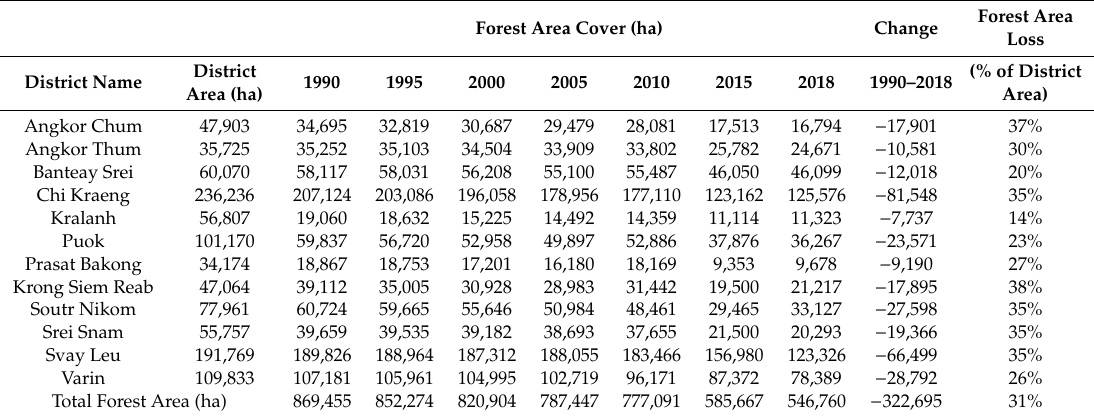
Table 8. District level forest land cover change. Forest Area Cover (ha)